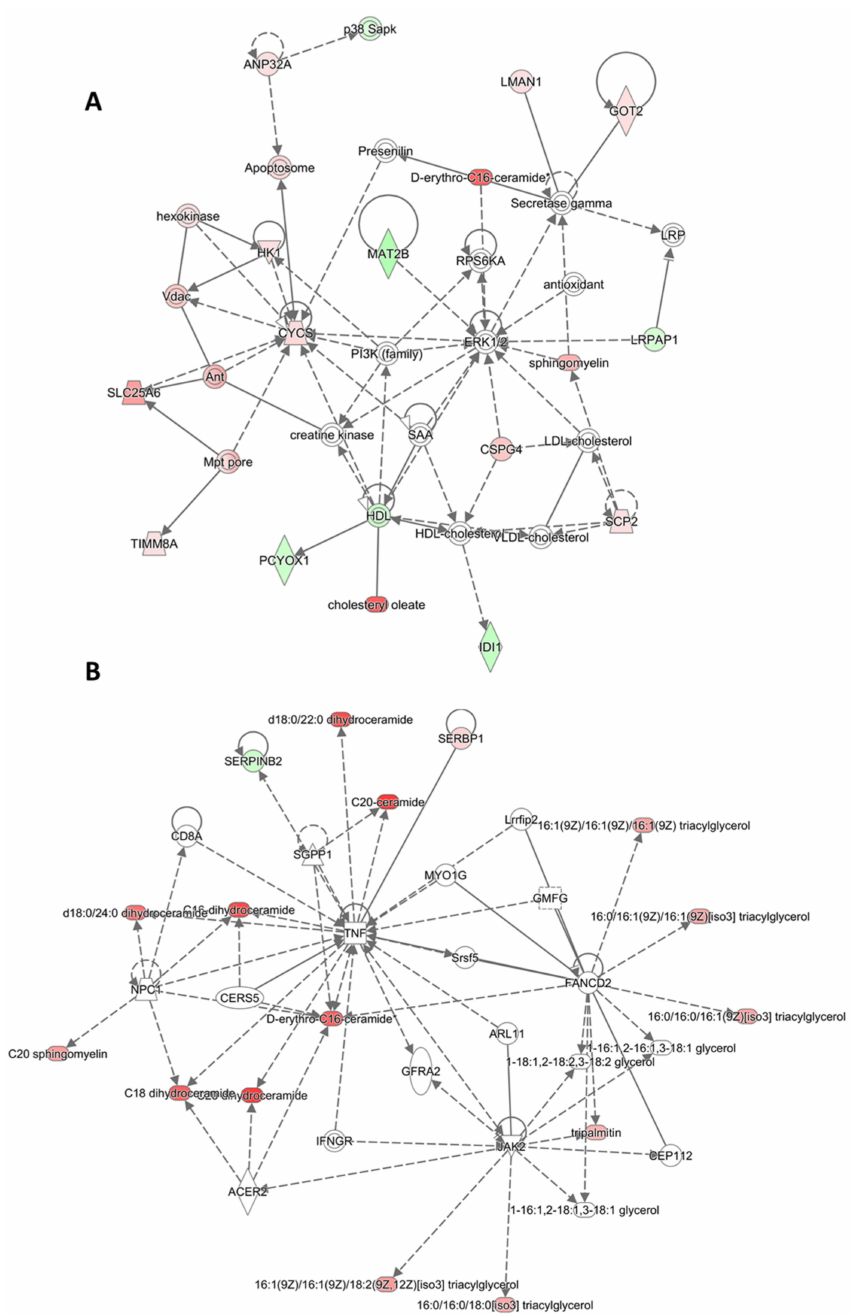
Figure 3. Networking between significantly altered proteins and lipids by LMW-HA 0.50% related to ( A ) mitochondrial activity and ( B ) inflammation. In red are the increased features covered by our input database, and in green are those decreased. The color intensity is positively related to the up or